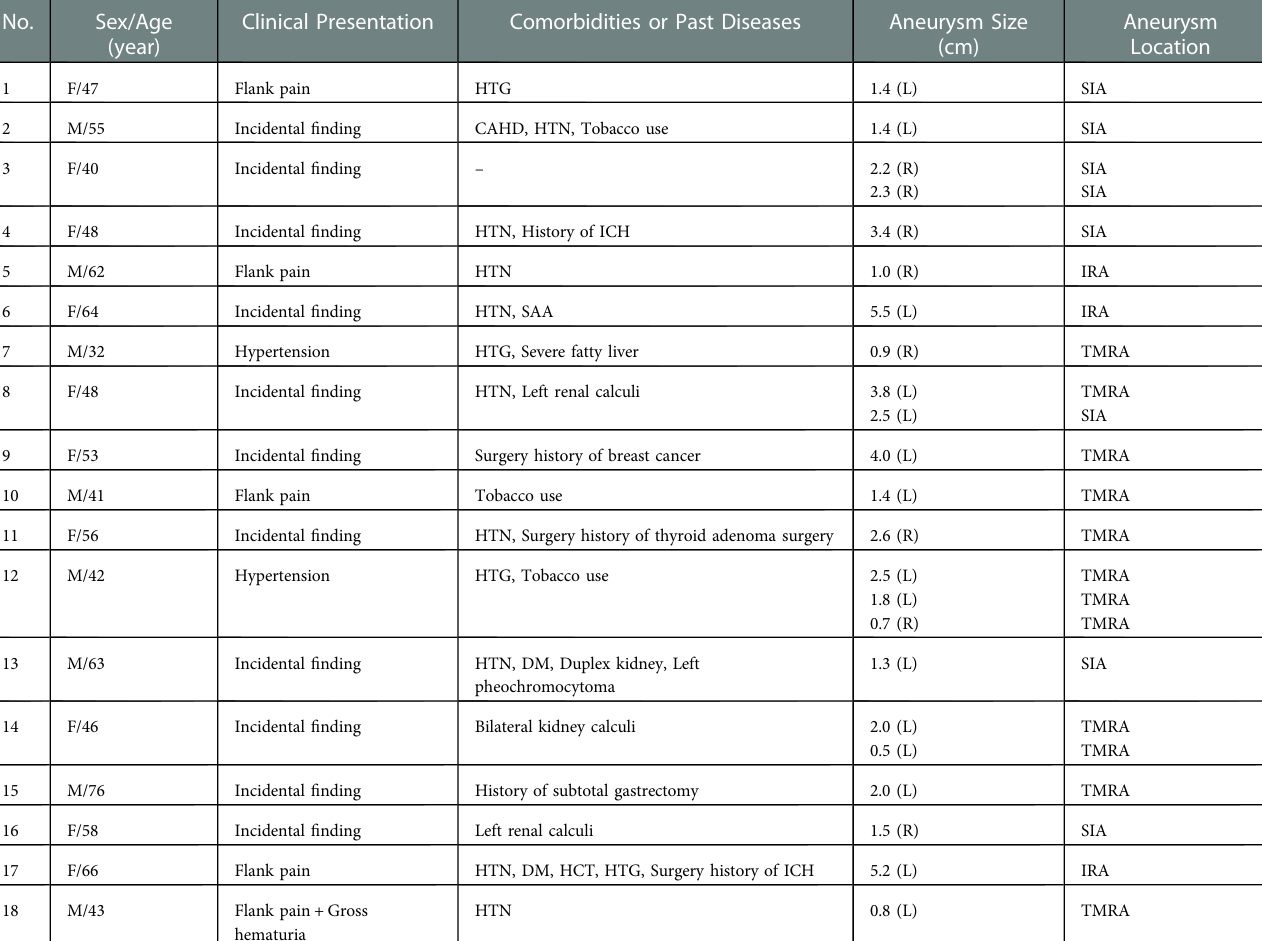
TABLE 1 Clinical parameters of 18 patients with true renal aneurysm.